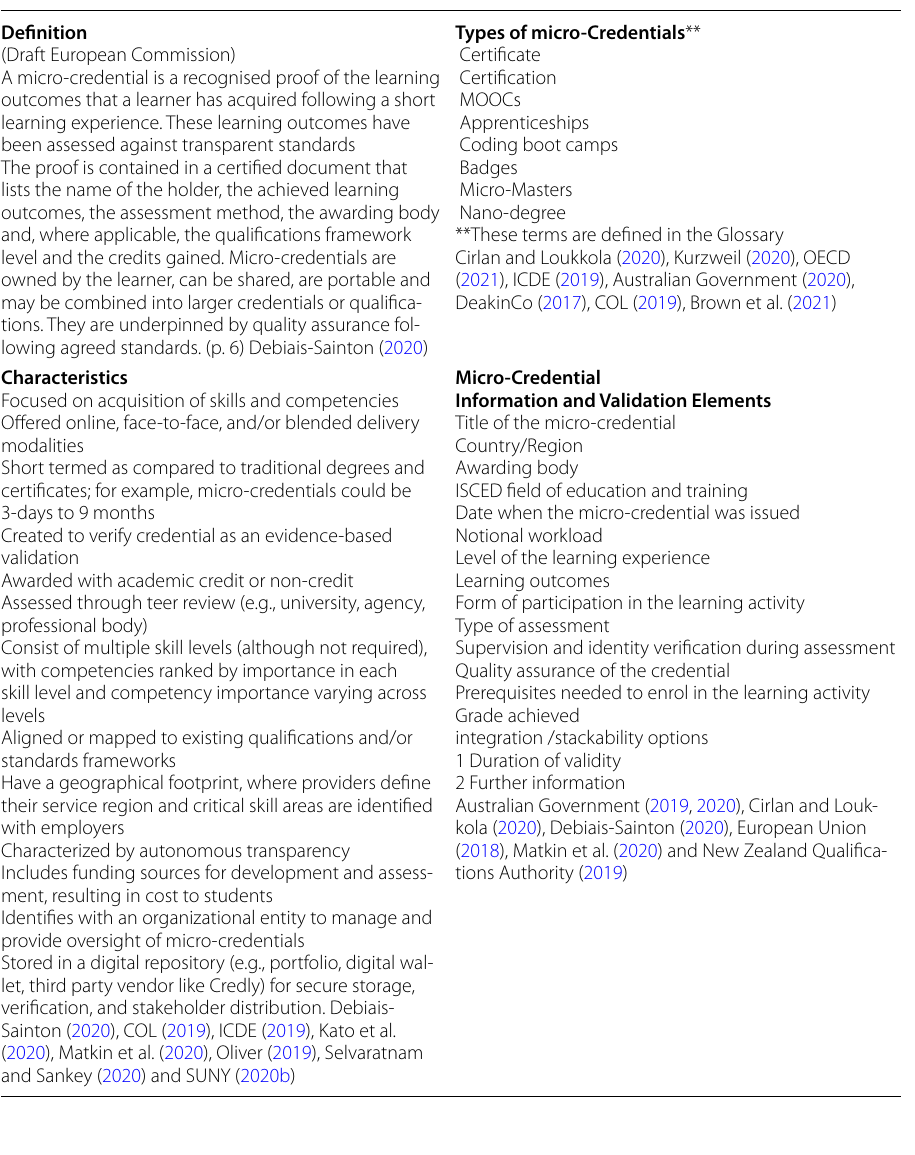
Table 1 A practical micro-credentials reference framework for university Leaders (McGreal et